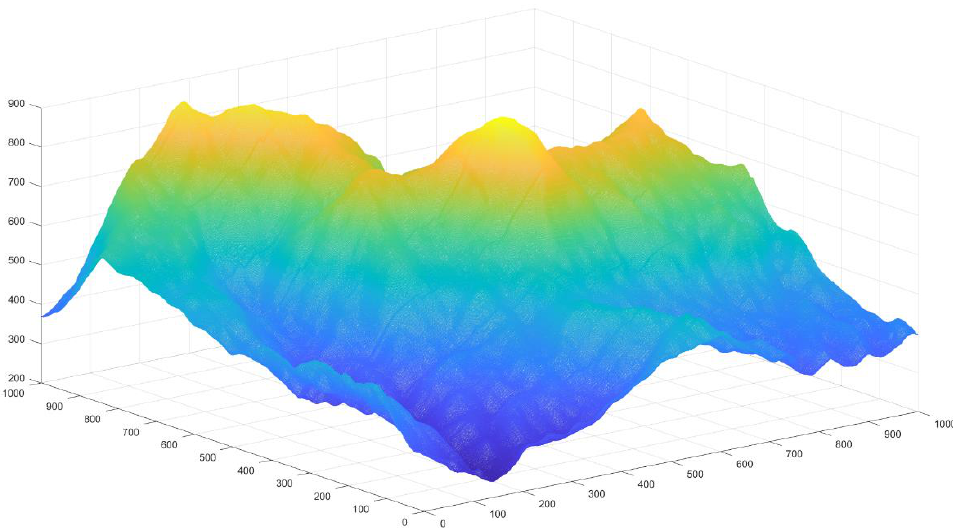
Figure 22. Terrain elevation values of the monitored area B.